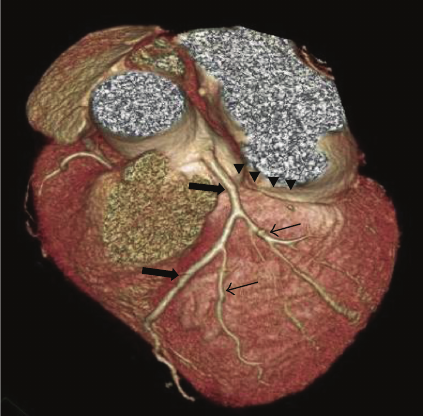
Figure 1: Top view three-dimensional computed tomography scan shows absent left circumflex artery in the atrioventricular groove (arrowed heads) with single left anterior descending artery (thick arrows) and prominent diagonal branches (thin arrows).